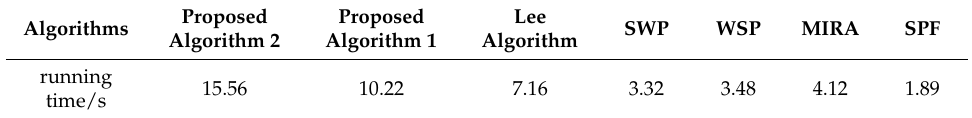
Table 2. The average running time of different algorithms to execute once.